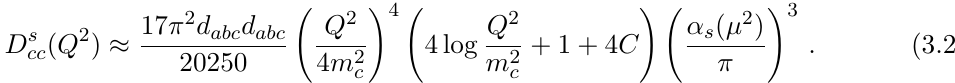
) = 0 . 115 (left) and 0 . 120 (right). GeV 2